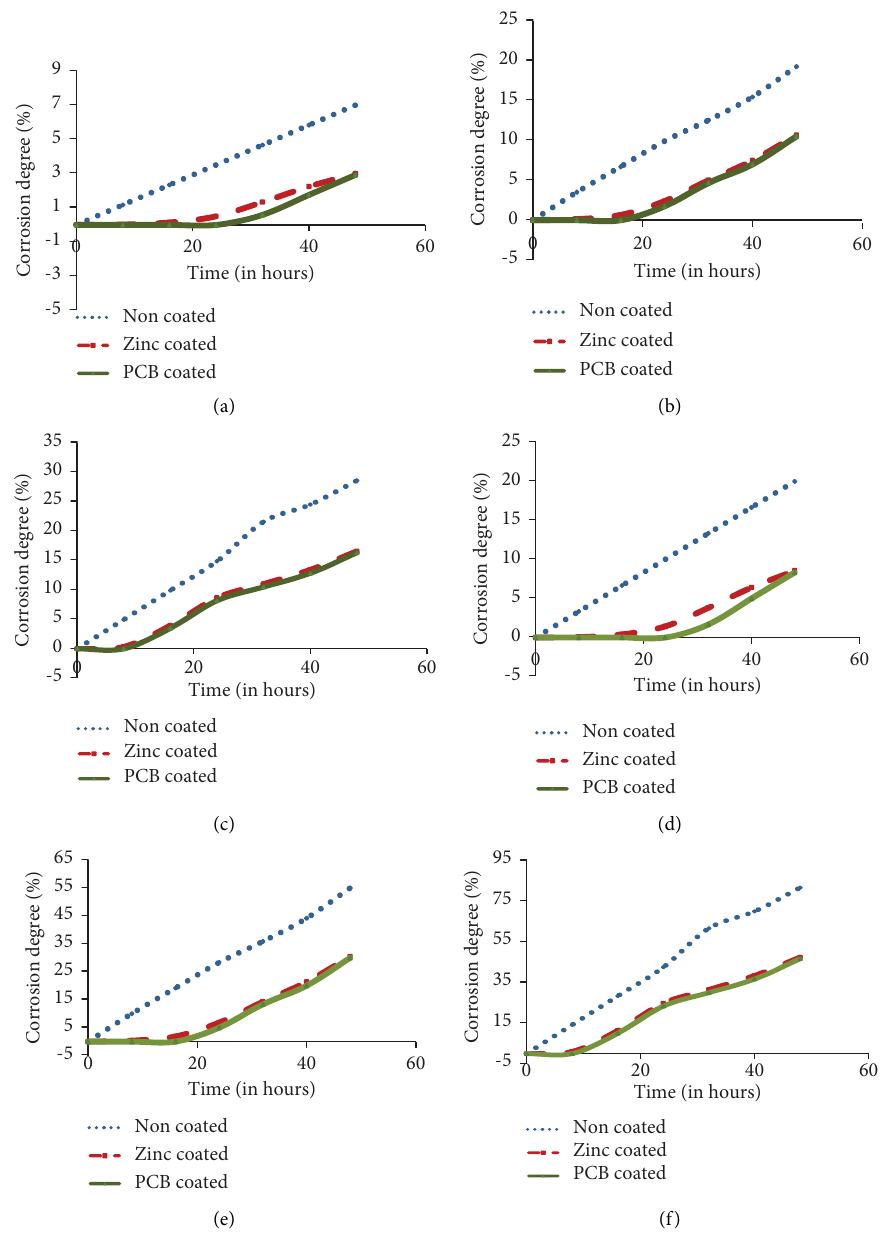
Figure 7: Comparison of degree of corrosion. (a) 2V (3.5% NaCl), (b) 4V (3.5% NaCl), (c) 6V (3.5% NaCl), (d) 2V (10% NaCl), (e) 4V (10% NaCl), and (f) 6V (10%